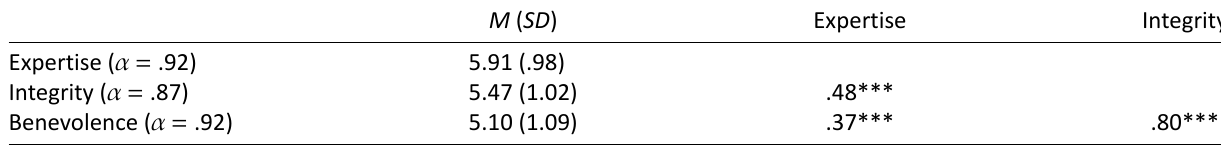
Table 3. Descriptive statistics and Pearson correlations for dimensions of trustworthiness. M ( SD ) Expertise Integrity Expertise ( 𝛼 = .92) Integrity ( 𝛼 =